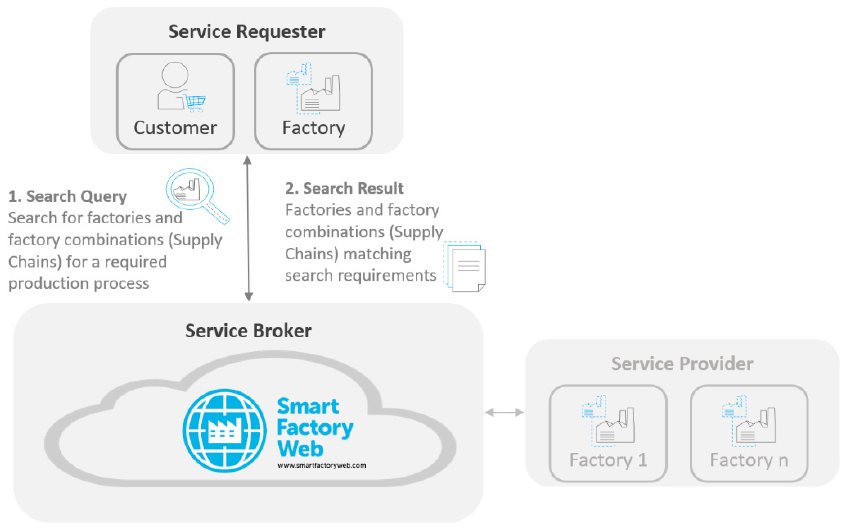
Figure 8. Search interface of the Smart Factory Web platform.